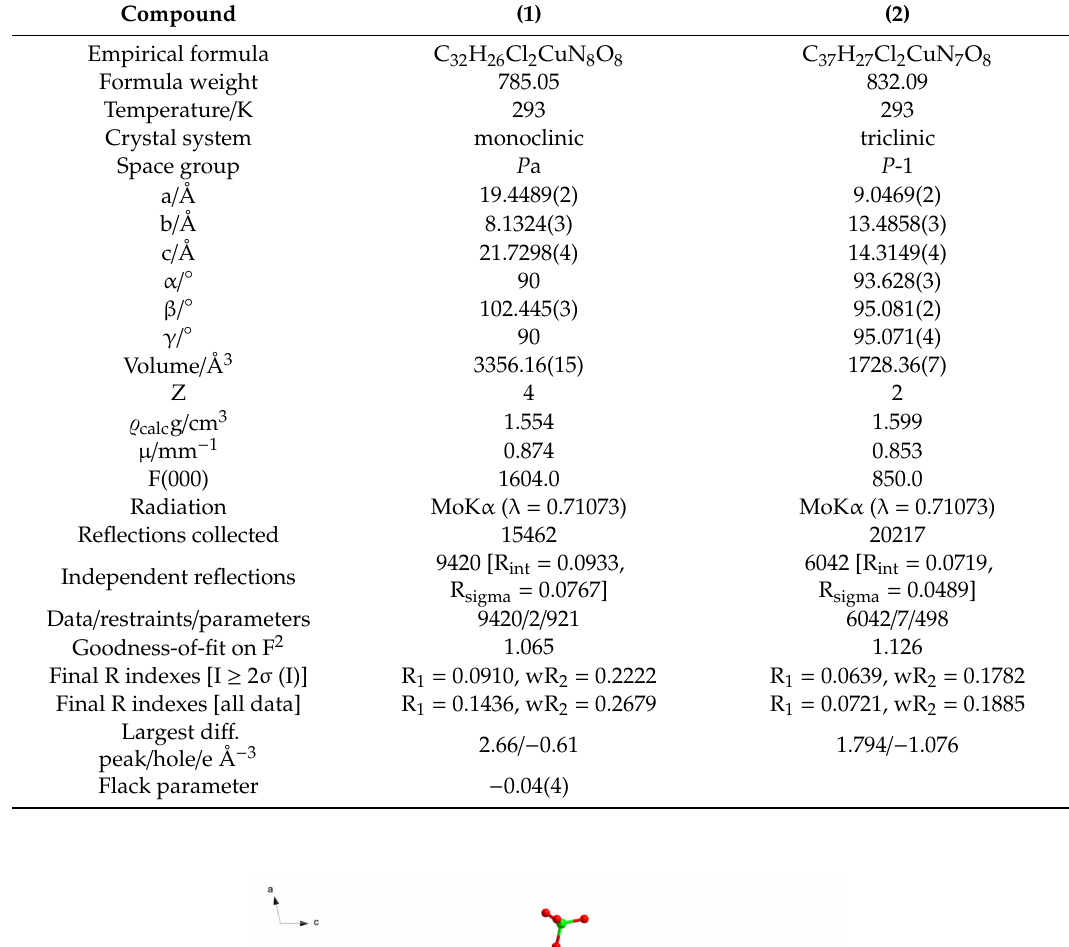
Table 1. Crystal data and structure refinement for compounds ( 1 ) and ( 2 ).